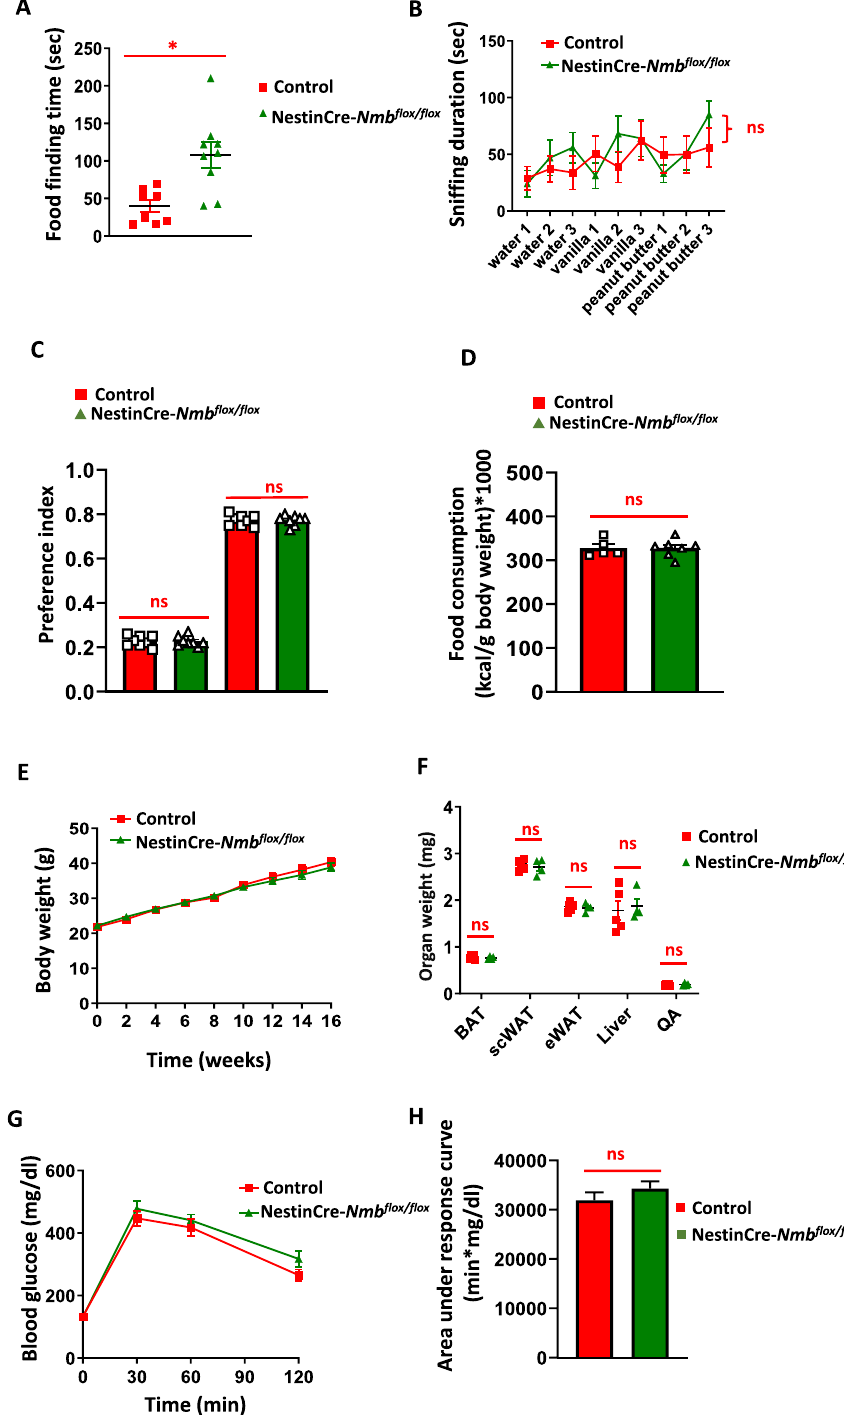
Figure 3. Nmb deficiency in the nervous system does not affect odor, food preference, body weight and adiposity under long term high fat diet. ( A) Standard food finding time after 16 h of food withdrawal. Each dot represents individual mice. ( B) Sniffing time after various odor presentation of control and NestinCre- Nmb flox/flox mice. n = 9–11 per group. ( C) 24-h food preference test between standard diet and high fat diet. Each dot represents individual mice. ( D) Food consumption of control and NestinCre- Nmb flox/flox mice fed for 16 weeks with high fat diet. Each dot represents individual mice. ( E) Body weight gain of control and NestinCre- Nmb flox/flox mice on high fat diet. n = 8–10 mice per group. One-way Anova with Bonferroni’s correction was used to compare the curves. ( F) Organ weight isolated from control and NestinCre- Nmb flox/flox mice fed for 16 weeks with high fat diet. Brown adipose tissue (BAT), subcutaneous adipose tissue (scWAT), epididymal adipose tissue (eWAT), quadriceps (QA). Each dot represents individual mice. ( G) IP GTT of control and NestinCre- Nmb flox/flox mice fed for 16 weeks with high fat diet. n = 7–10 per group. ( H) Area under the curve of IP GTT under high fat diet conditions. n = 7–10 mice per group. Data are shown as means ± SEM. Each dot represents individual mice. * p < 0.05, ** p < 0.01, *** p < 0.001, and **** p < 0.0001, ns not significant. For curve comparison, one-way Anova with Bonferroni correction was used, otherwise unpaired Student t-test was used to determine statistical